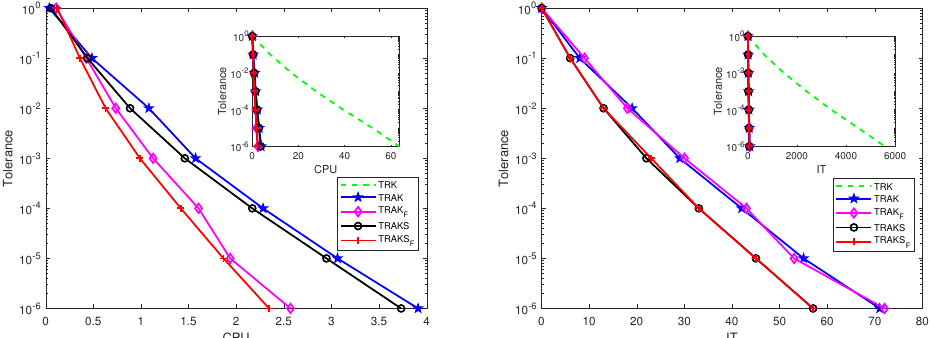
Figure 5. Pictures of tolerance versus IT and CPU times for the TRK, TRAK, TRAK F , TRAKS, and TRAKS F algorithms when X is synthetic